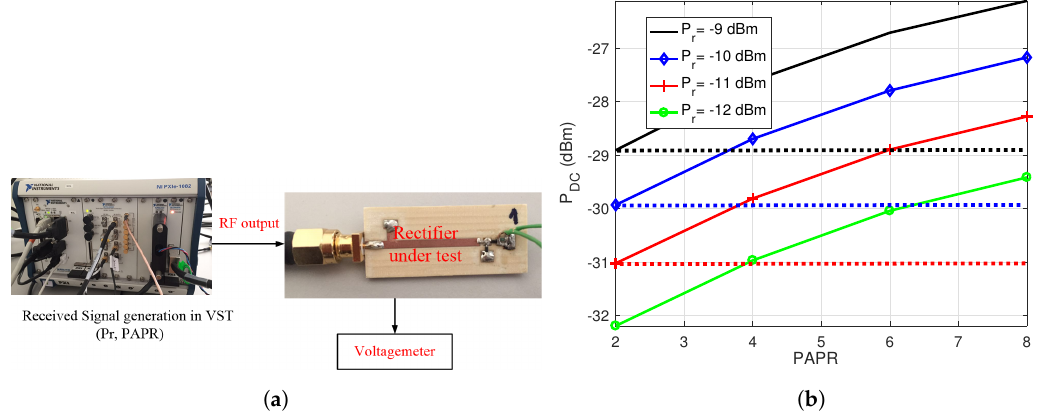
Figure 5. ( a ) Measurement set-up and ( b ) measured DC output power P DC with increasing PAPR of the signal at different power levels; the dotted lines of the same color plot the corresponding P DC using CW signal